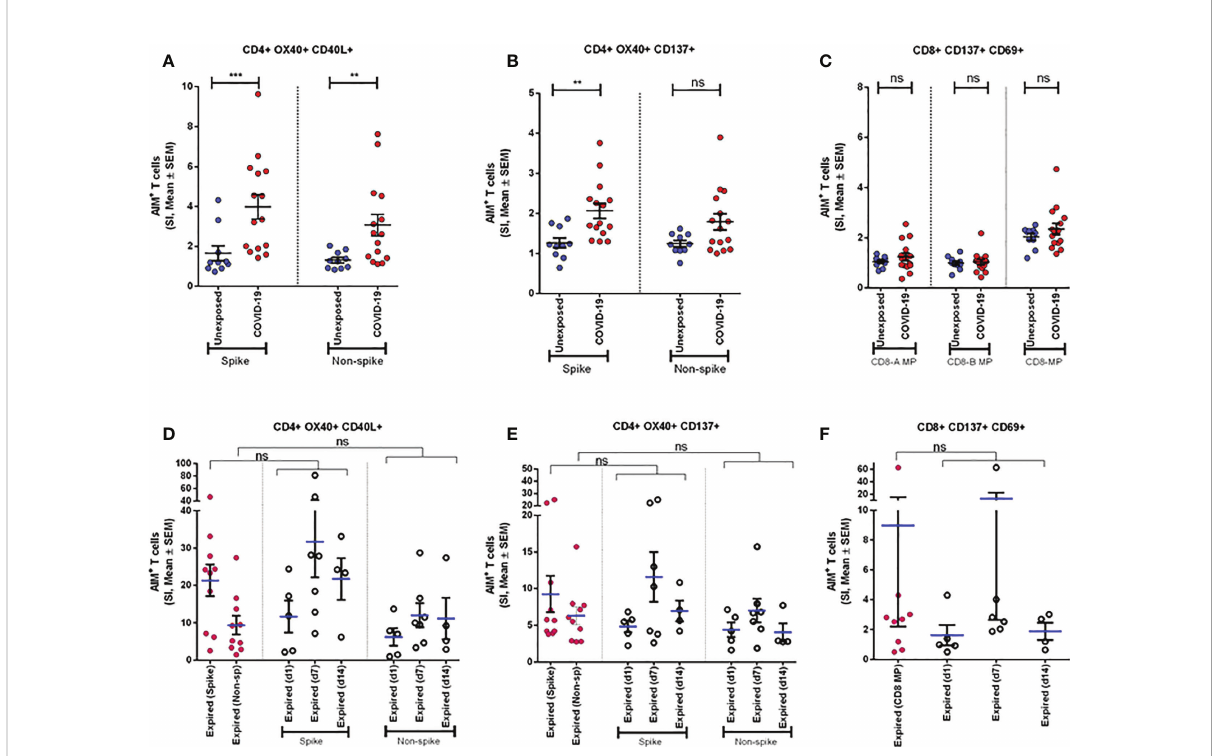
FIGURE 4 Antigen speci fi c response to different CD4+ and CD8+ AIM markers. (A-C) AIM expression in Unexposed (n=10) & COVID-19 participants (n=15). Stimulation Index (SI) quantitation of the AIM+ T cells after stimulation with CD4-nCOV-Spike, Non-spike (CD4-nCOV-all MP), and the class I CD8 peptide MPs (CD8-A and CD8-B). COVID-19 patient samples are collected after one month (day 28) after infection. (D-F) AIM expression in “ Expired ” participants. The left column (purple) shows SI of expired participants (n=10) from samples collected immediate visit before their death. Ordinary one-way ANOVA (with Tukey ’ s multiple comparison test) was done to compare the groups (for D-F ). The fi gure shows the mean SI with error bars representing standard errors of the means (mean ± SEM). Statistical comparisons were performed by a two-tail Mann- Whitney test (for A-C ). **p<0.01; ***p<0.001; ns: non-signi fi